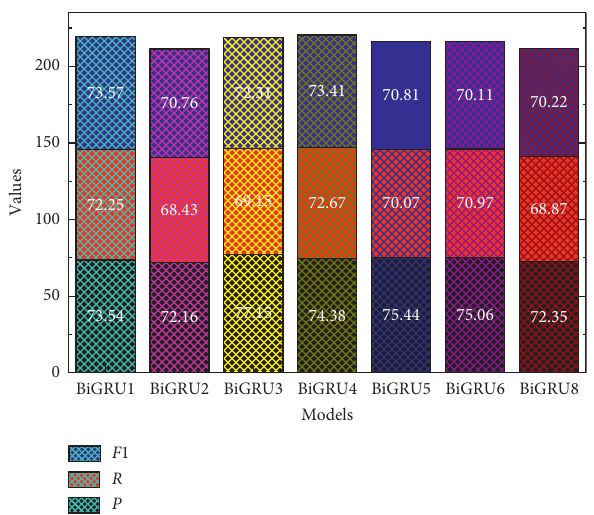
Figure 4: Effect of different input features on model